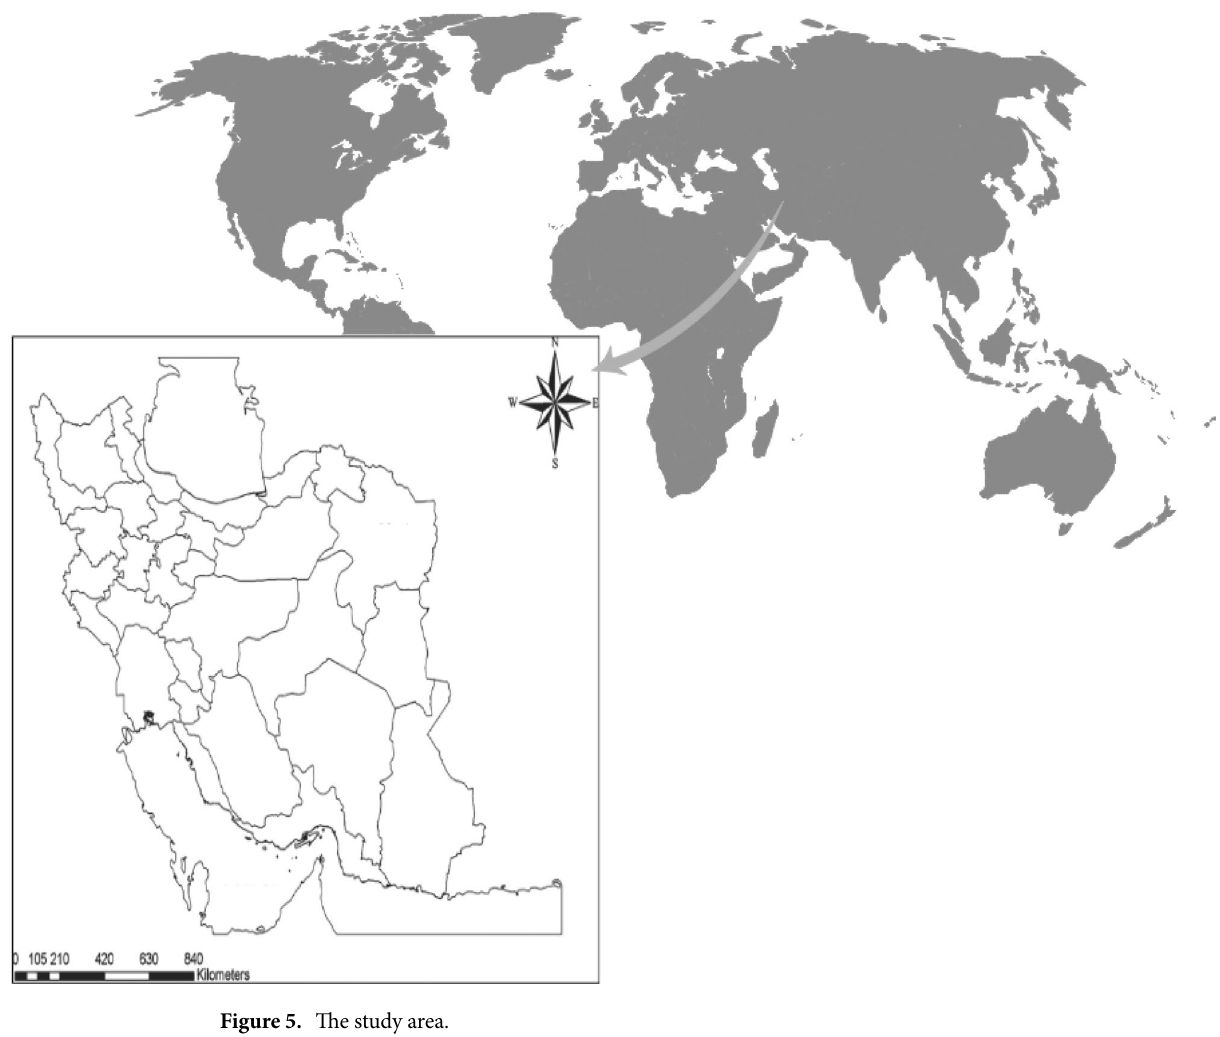
Figure 5. The study area.